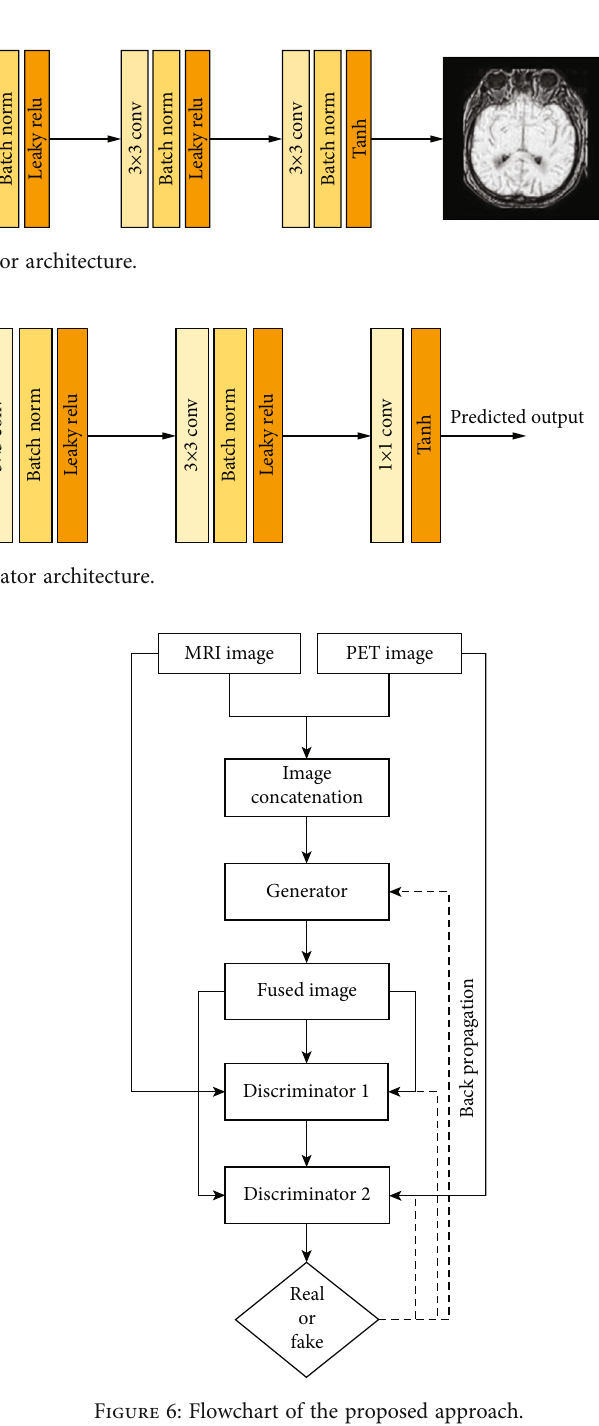
Figure 6: Flowchart of the proposed